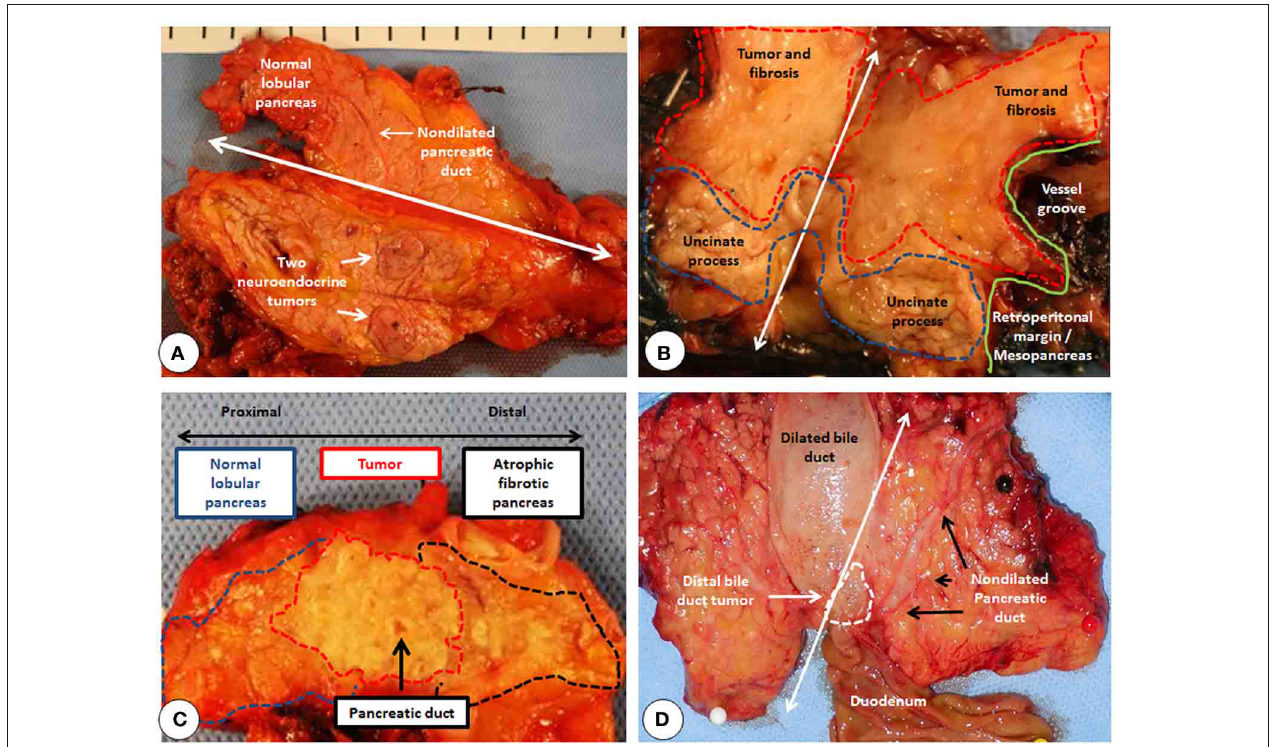
microscopic assessment of the R-Status of the resection. (C) The resected pancreatic body is cut open longitudinally in the middle. Notice the proximal demarcation of the desmoplastic tumor from the normal lobular pancreas. Distally however, due to the ductal obstruction and repetitive pancreatitis bouts, pancreas is atrophic and fibrotic. (D) The resected pancreatic head is cut open along the white double headed arrow. White dotted line marks the small distal bile duct tumor. Notice the lack of fibrosis and dilatation of the pancreatic duct despite massive dilatation of the bile